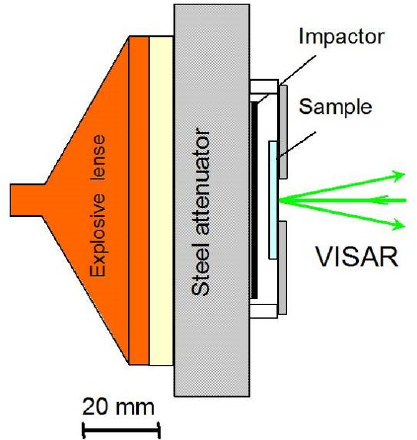
Figure 2. Scheme of experiments on shock-wave loading of the samples.